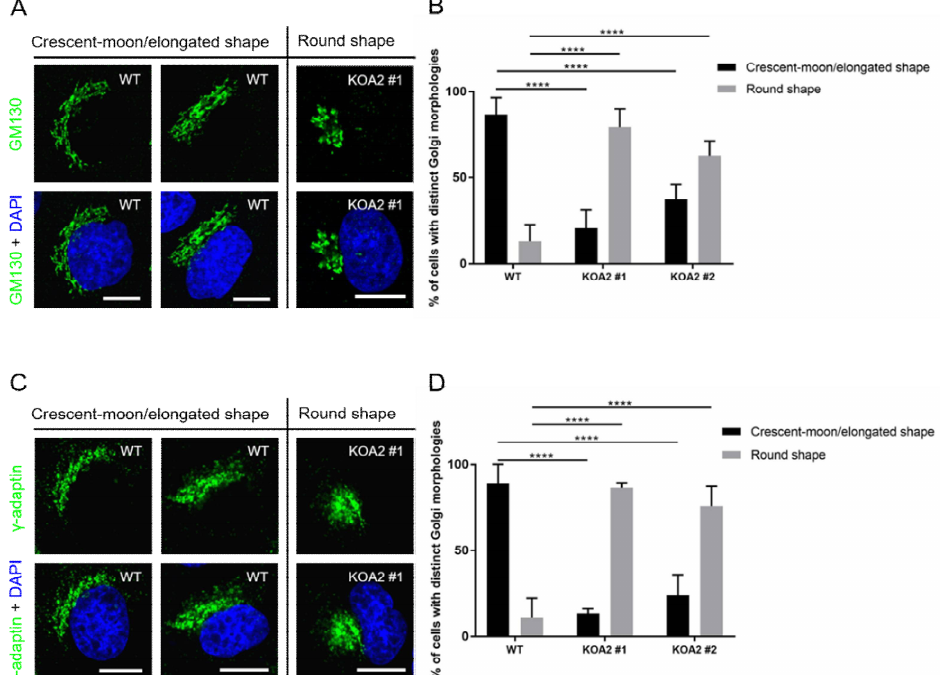
Figure 6. SLC35A2 deficiency triggers Golgi compaction. ( A , C ) Representative images of distinct Golgi morphologies. GM130 ( A ) and γ-adaptin ( C ) are shown in green and cell nuclei are shown in blue. Scale bar corresponds to 10 μm. The way of data presentation was inspired by [41]. ( B , D ) Quantitative analysis of the percentage of cells with distinct shapes of the cis Golgi compartment ( B ) and TGN ( D ) in the wild-type and SLC35A2 knockout cells. Data are presented as mean ± SD (7–8 images and 104–117 cells were analyzed for each cell line). Asterisks indicate statistically im- portant differences between wild-type cells and individual clones. The significance level was set at p ≤ 0.0001 (****). Data were analyzed using ordinary one-way ANOVA with post hoc (Tukey’s multiple comparisons) test.